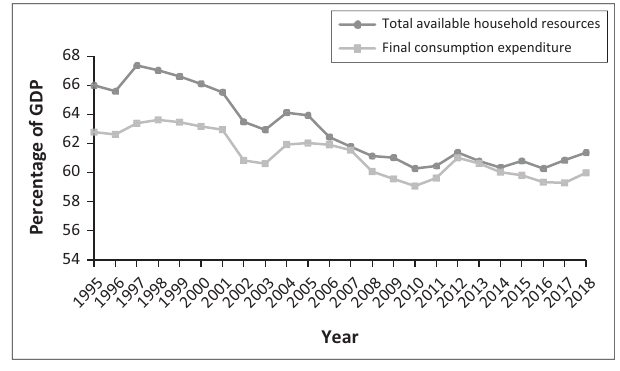
GDP, Gross domestic product. FIGURE 1: Total available household resources and final consumption expenditure, 1995 to 2018.